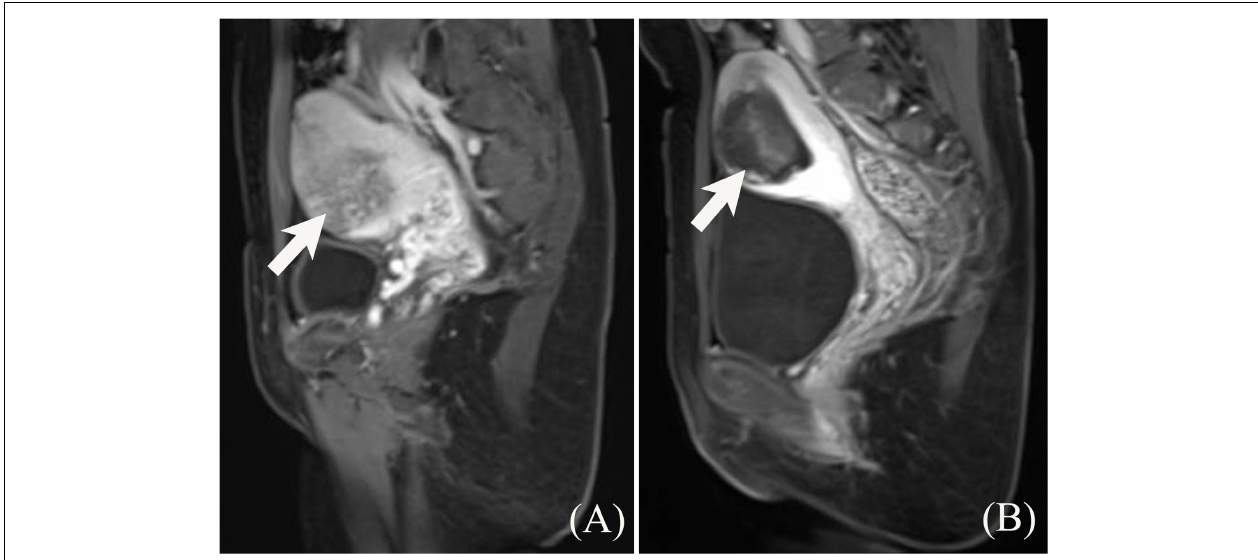
FIGURE 2 | Contrast enhanced MRI of A 23-year-old woman with placenta increta before and after HIFU treatment. (A) The depth of placenta invasion was 3.7 cm, close to the uterine serous surface, and uniform enhancement of the implanted placenta with perfusion slightly below the myometrium. (B) After HIFU treatment, contrast enhanced MRI shows no perfusion of the placental